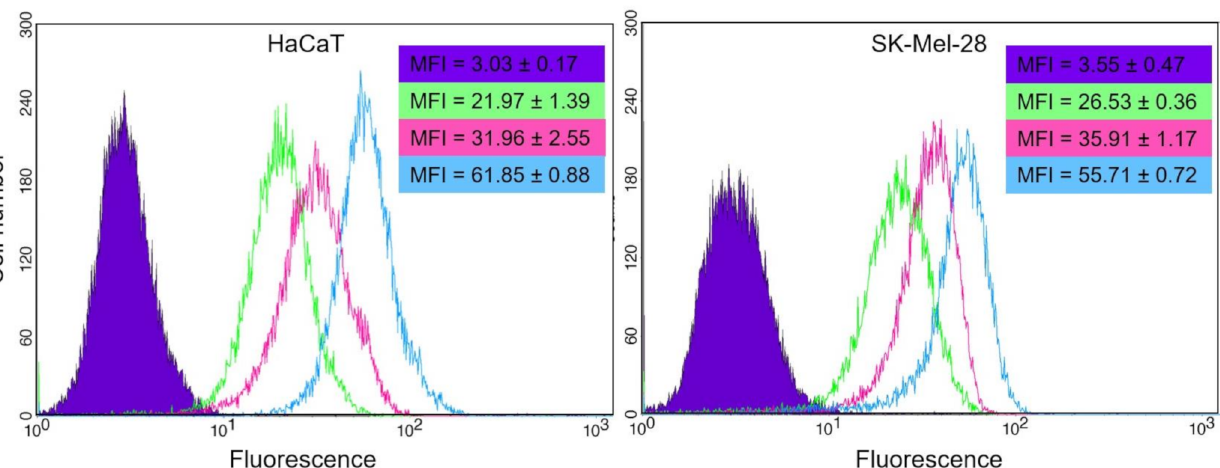
Figure 6. Detection and comparison of induction of apoptosis in ( HaCaT ) and ( SK-Mel-28 ) by flow cytometry. Cells were analyzed after 4 h of incubation with free Vismodegib (Vis) and UDL-Vis. The events were detected using Annexin V-FITC and propidium iodide. The presented dot plots correspond to one of the three independent determinations, and the quadrants’ percentage values are the mean ± SD of those experiments ( n = 3).